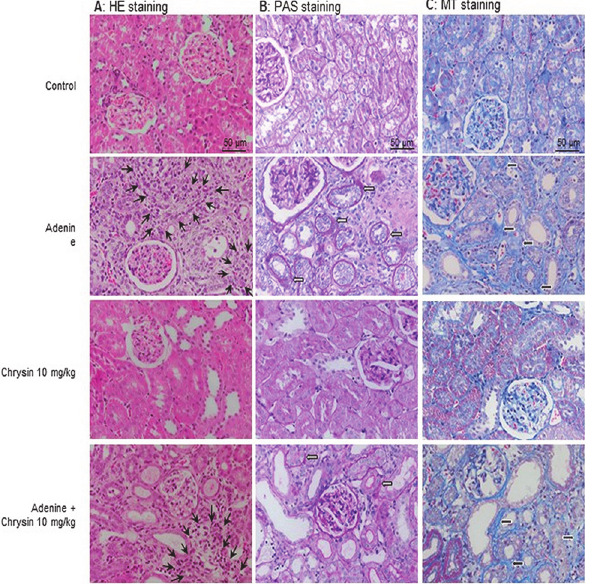
Fig 7. Effect of chrysin on adenine-induced morphological changes in the kidney. Representative pictures of kidney slices of the control group, the adenine group, the chrysin 10mg/kg group and the adenine plus chrysin 10 mg/kg group used for semi-quantitative scoring of inflammation and fibrosis. (A) HE staining used for the identification and semi-quantitative scoring of inflammation. The black slender arrows point to examples of leucocyte infiltration (20-fold magnification). (B) PAS staining, used for the identification and semi-quantitative scoring of atrophy of the basal membrane and dilatations. The white filled arrows point to examples of atrophic basal membranes (20-fold magnification). (C) MT staining, used for identification and semi-quantitative scoring of fibrosis. The black filled arrows point to collagen deposition, characteristic for fibrosis (20-fold